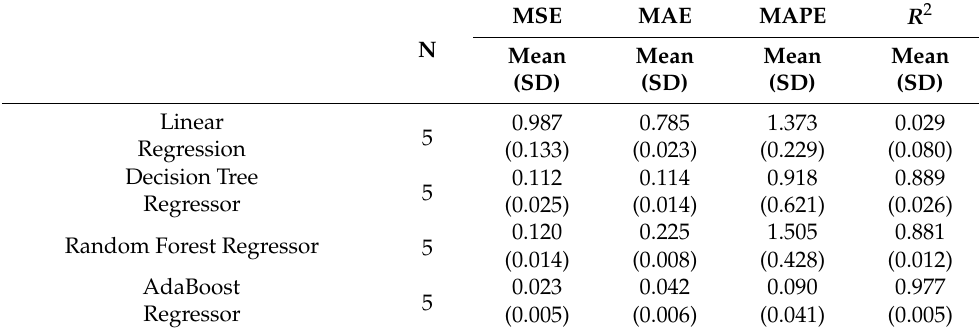
Table 10. The prediction performance of test data.